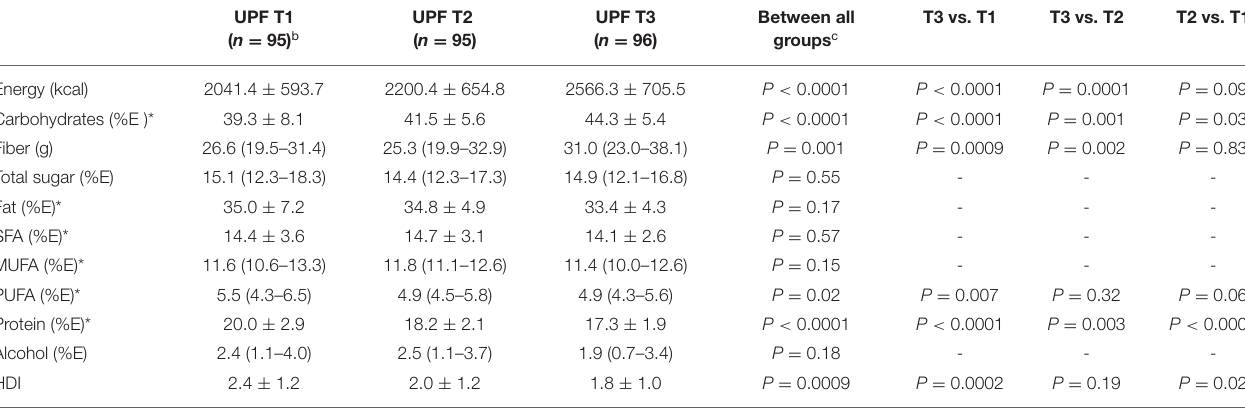
TABLE 2 | Nutrient composition between tertiles of ultra-processed food (UPF) a